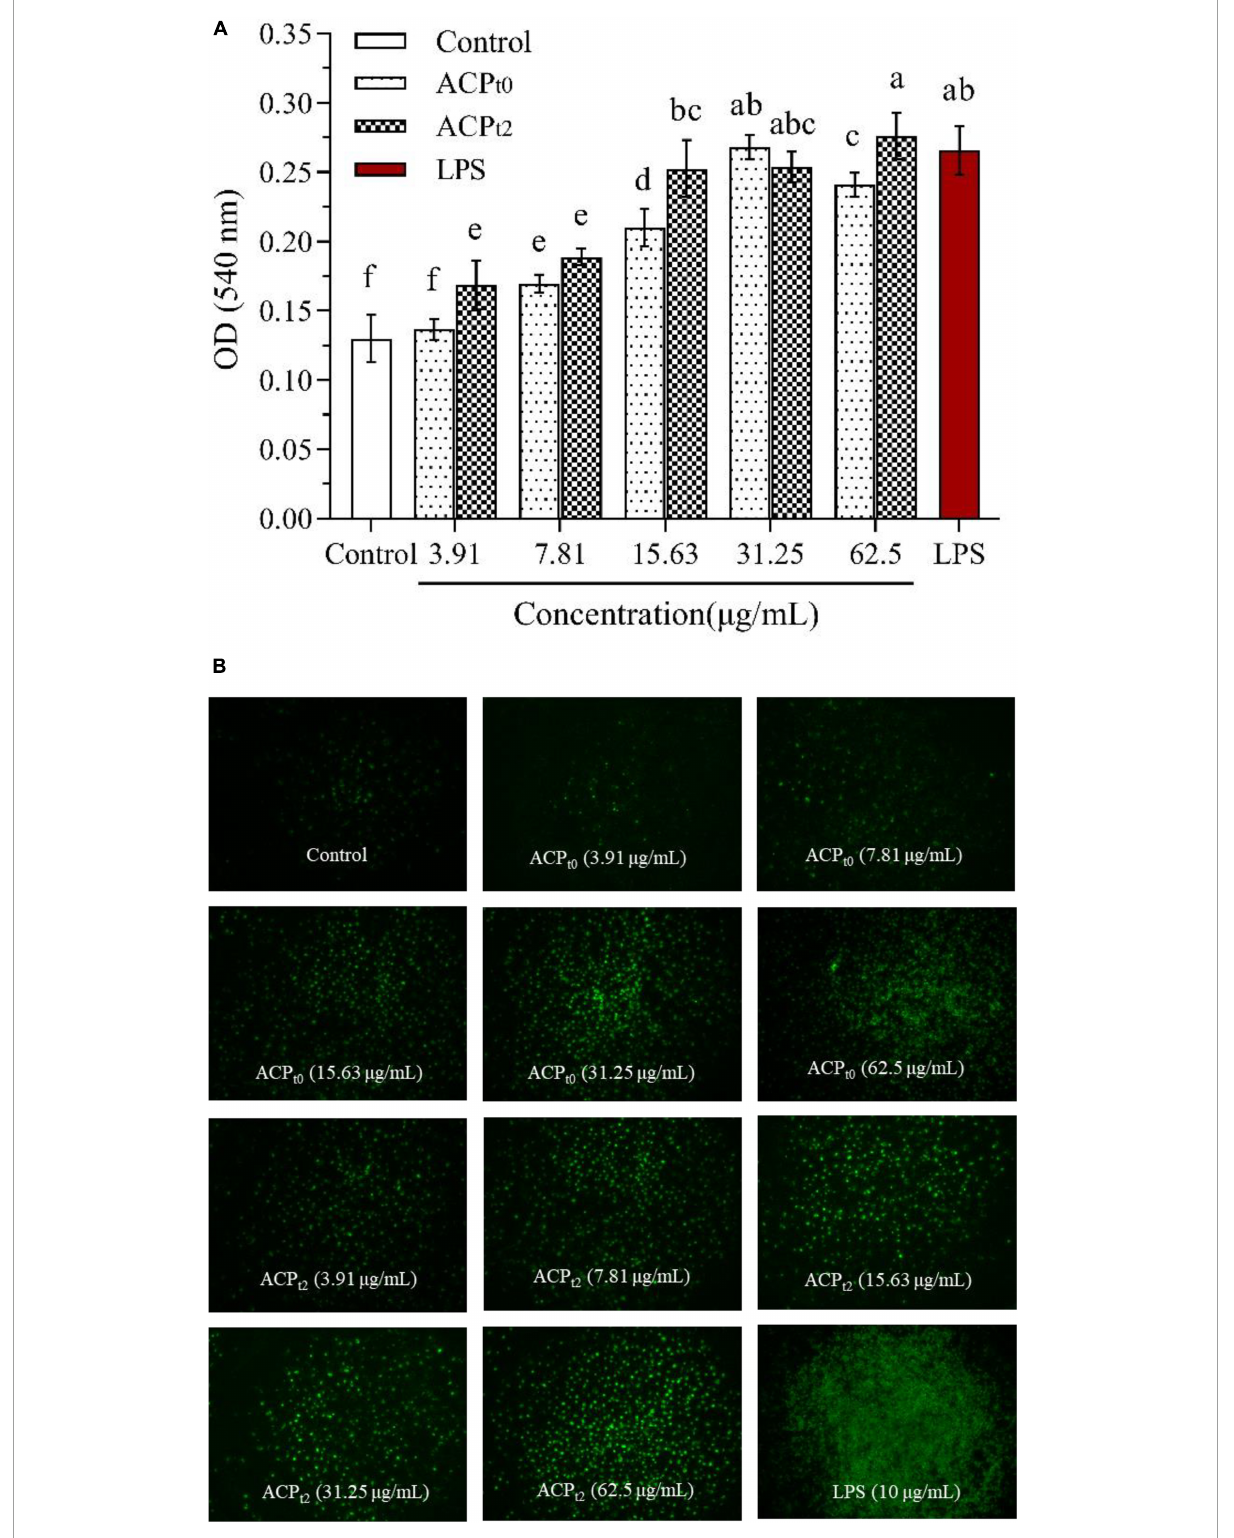
FIGURE5 Pinocytiosis rate of ACP t 0 and ACP t 2 on taking neutral red of macrophages (A) . Fluorescence microscopic images of macrophages phagocytosing FITC-labeled E. coli (B) . The different letters in the column indicate statistically significant differences ( P < 0.05).